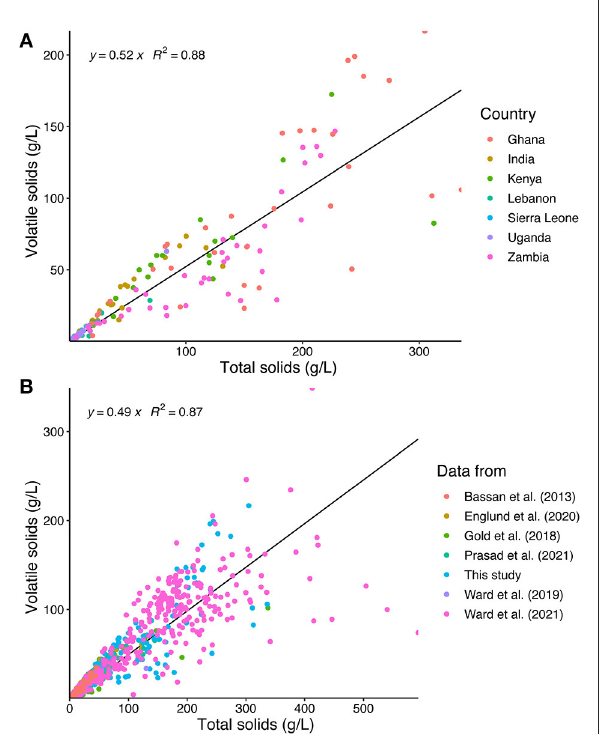
FIGURE6 Linear correlation between TS and VS, with trend lines forced through origin. (A) For all locations in this study combined. (B) This study with other available datasets (total n = 1,206): Burkina Faso ( n = 56) (Bassan et al., 2013); Uganda and Vietnam ( n = 240) (Englund et al., 2020); Japan, Switzerland, Uganda, Vietnam ( n = 91) (Gold et al., 2018); India ( n = 164) (Prasad et al., 2021); Ghana, India, Kenya, Lebanon, Sierra Leone, Uganda, Zambia ( n = 204) (this study); Senegal and Tanzania ( n = 25) (Ward et al., 2019); and Zambia ( n = 426) (Ward et al., 2021b).